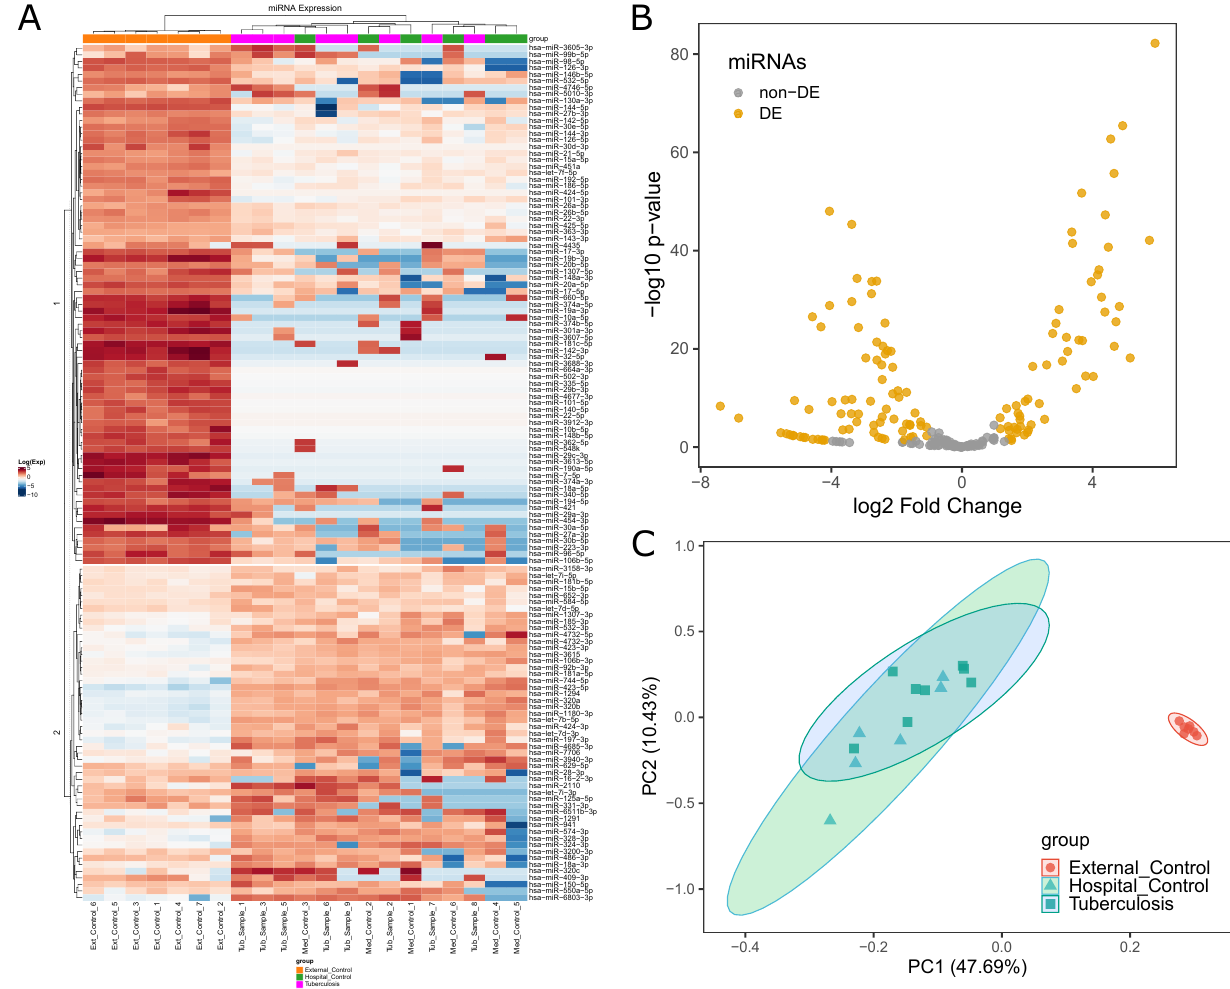
Figure 2. Differential miRNA expression analysis between Medical Samples and External Controls: ( A ) differences in miRNA expression levels between the three initial groups (EC, orange; HC, pink; TP, green) represented by a heatmap; ( B ) volcano plot highlighting 130 DEmiRNAs in Medical Samples versus External Controls; and ( C ) PCA plot showing distances between the three initial groups based on miRNA